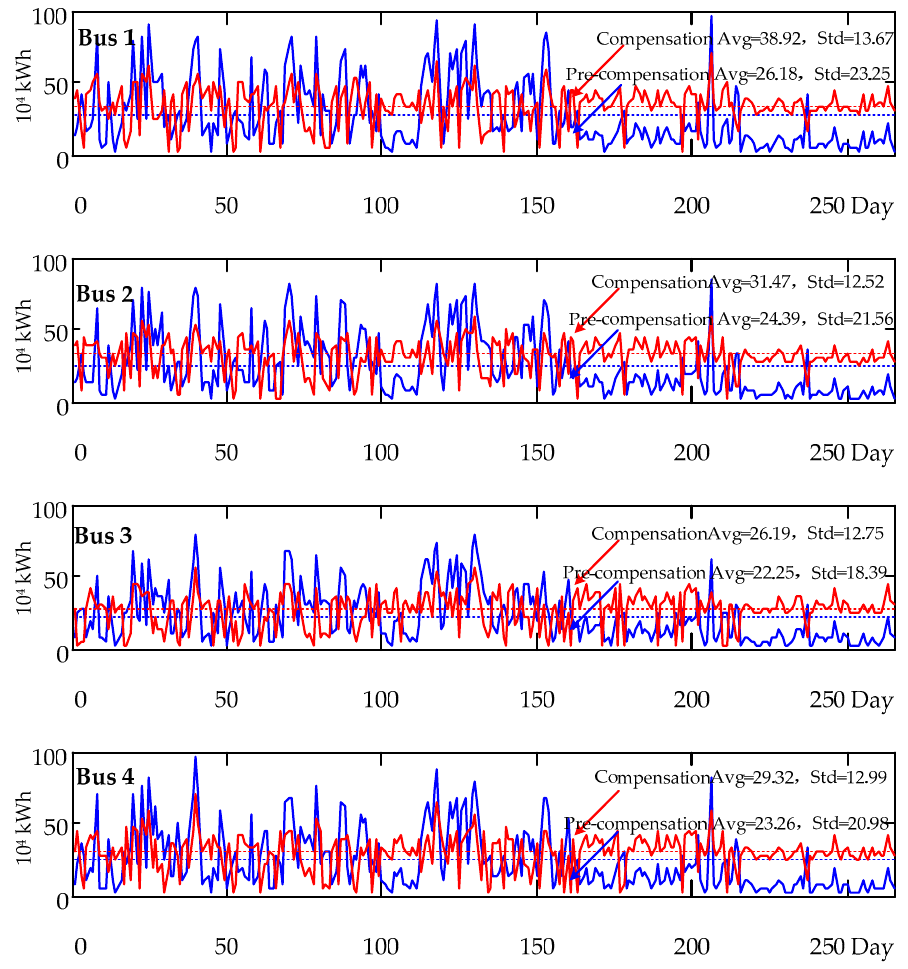
Figure 14. P R > Avg ( P R ) battery charging, P R < Avg ( P R ) battery discharging.